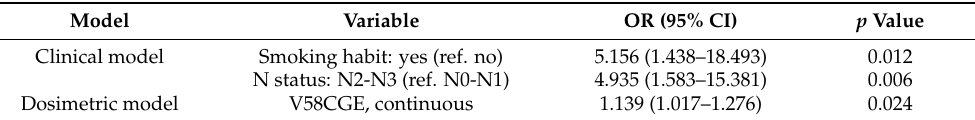
Table 3. Logistic regression model to predict grade 2 and 3 acute radiation dermatitis.